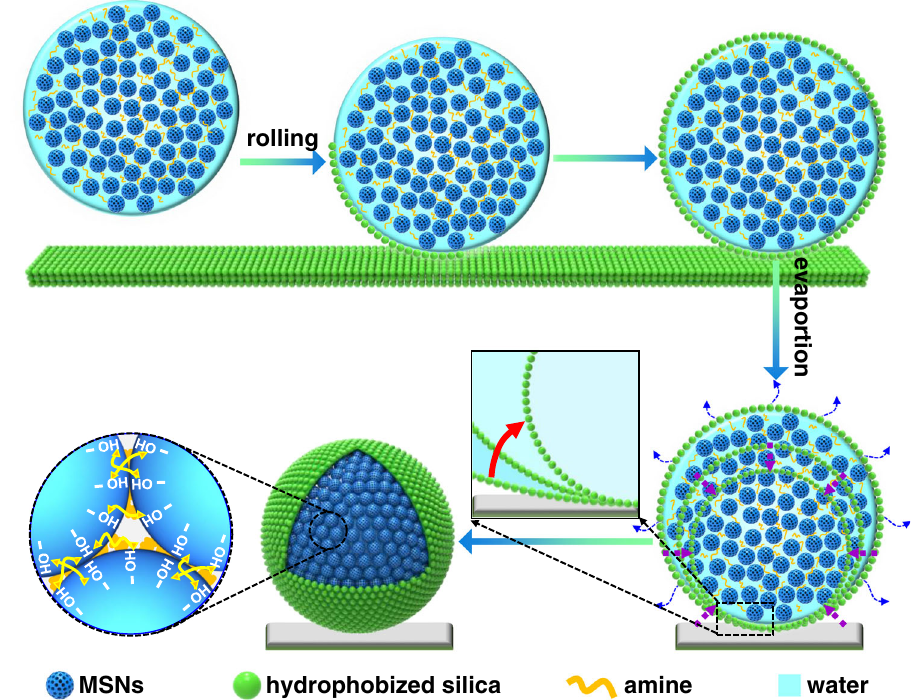
Fig. 1 | Schematic illustration of the preparation of SPs. Droplets of TEPA solu- tion containing MSNs are dropped onto a bed made of hydrophobized